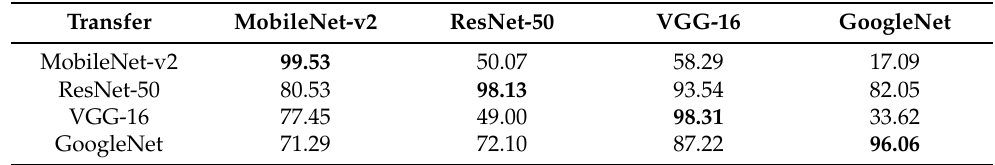
Table 2. Transferability —represented by the attack success rate (%)—of ADSAttack among different deep learning